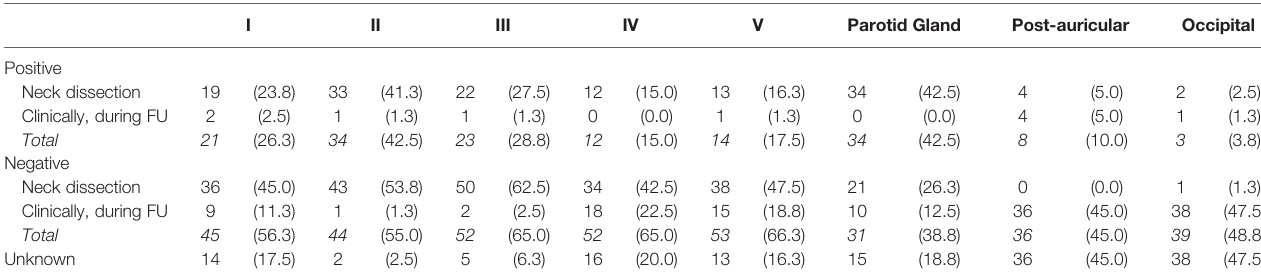
TABLE 2 | Ipsilateral outcome per lymph nodal level during histopathological examination or during clinical follow-up within 2 years by physical examination or